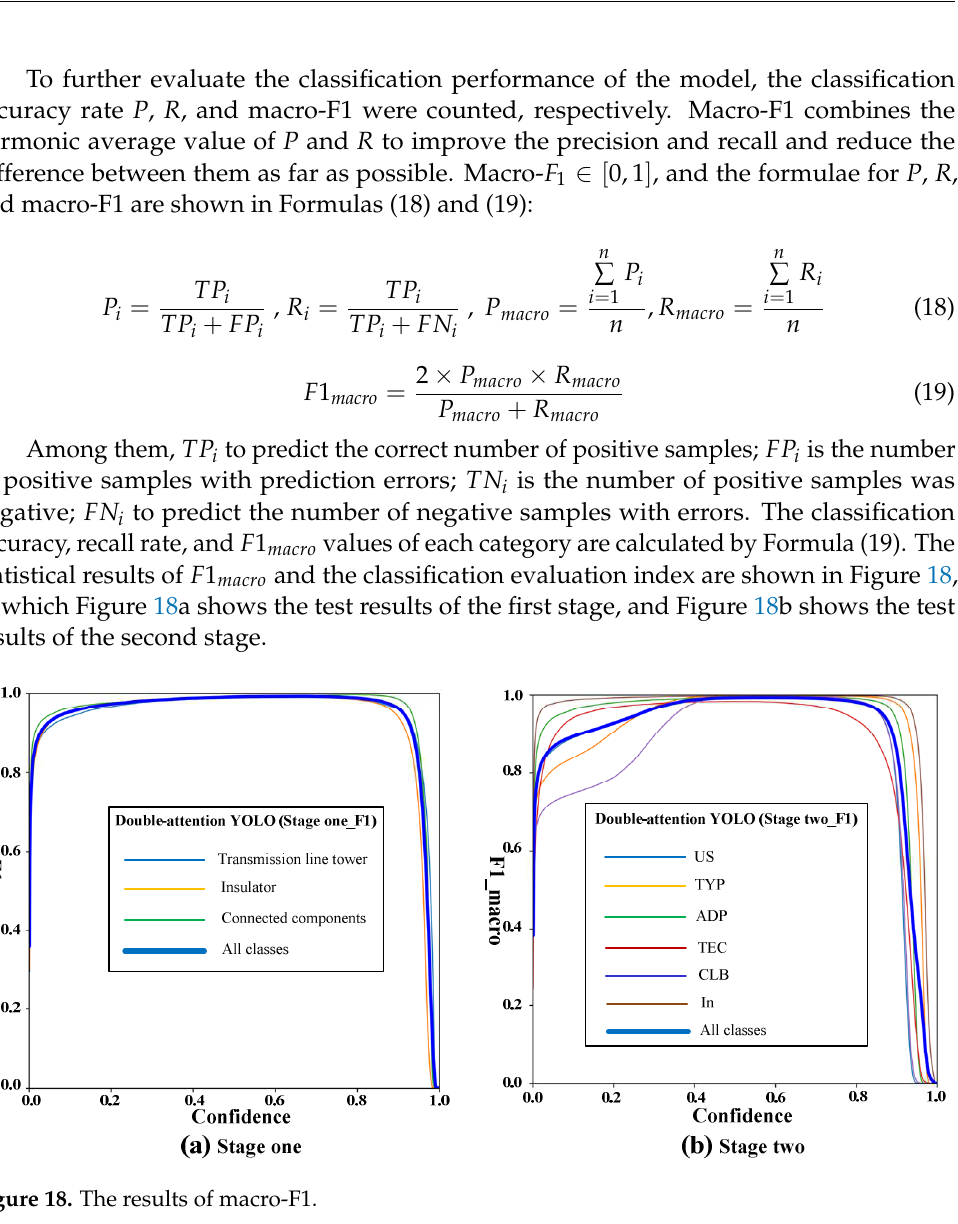
Table 2. Verification results under different backbone components (Stage one).